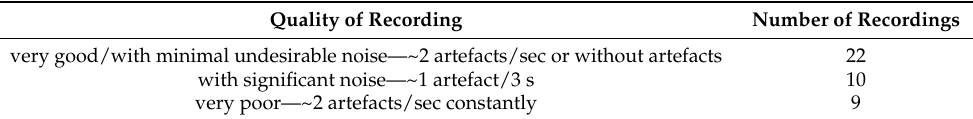
Table 1. Dividing of recordings.